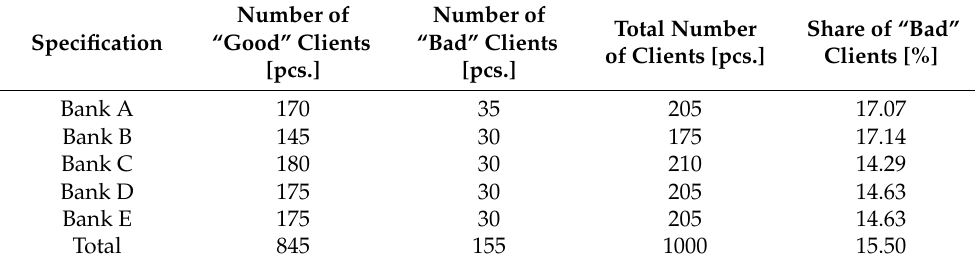
Table 1. Structure of the surveyed